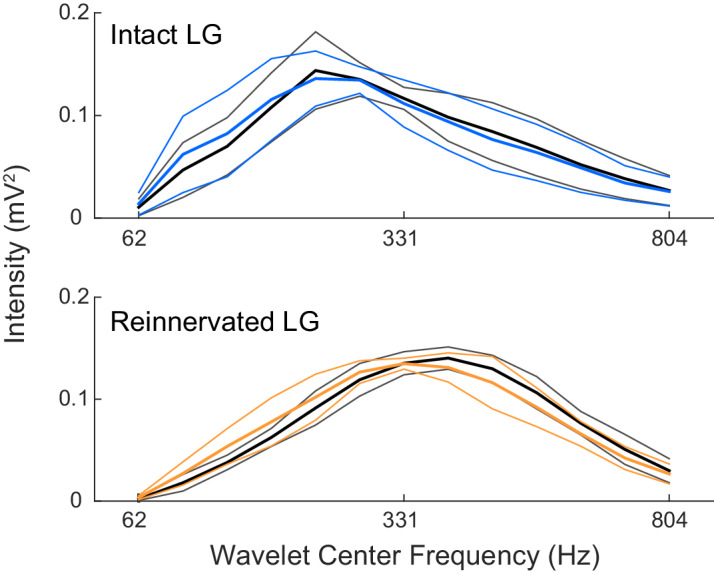
LG frequency distribution.Distribution of EMG activation frequency (mean ±95% ci) for intact LG (top, blue) and reinnervated LG (bottom, orange), during level running (dark grey lines) and obstacle encounters (S 0, colored lines). Note the shift in peak frequency of EMG activity in the reinnervated LG for both level terrain and obstacle strides, suggesting recruitment of faster motor units.